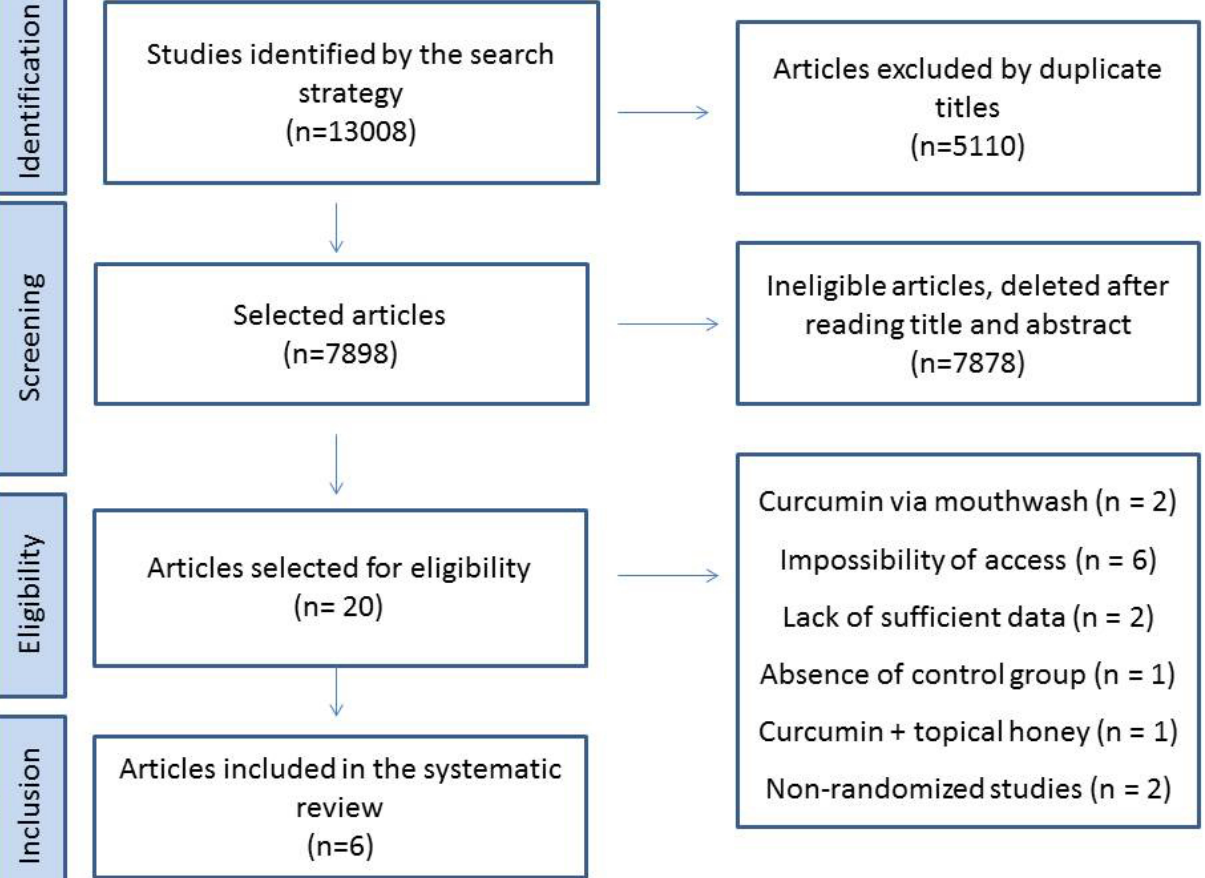
FIGURE 2 – PRISMA illustrative diagram of the systematic search incorporated in this